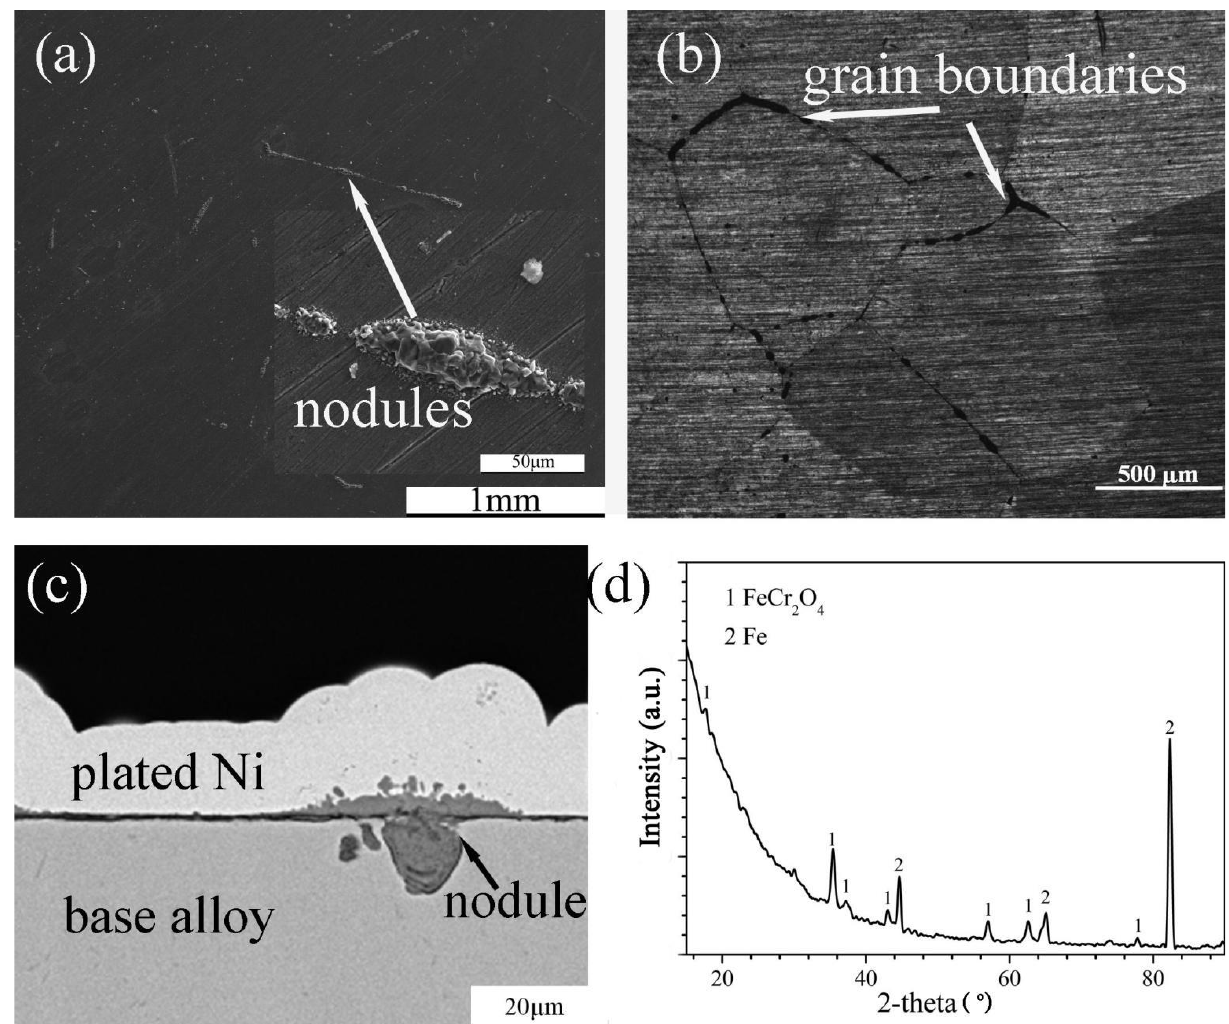
Figure 4. Surface morphology: ( a ) SEM, ( b ) OM, cross-sectional image: ( c ) SEM and XRD spectrum ( d ) of Fe-5Cr-5Si alloy oxidized in H 2 -CO 2 mixture at 600 °C for 24 h.